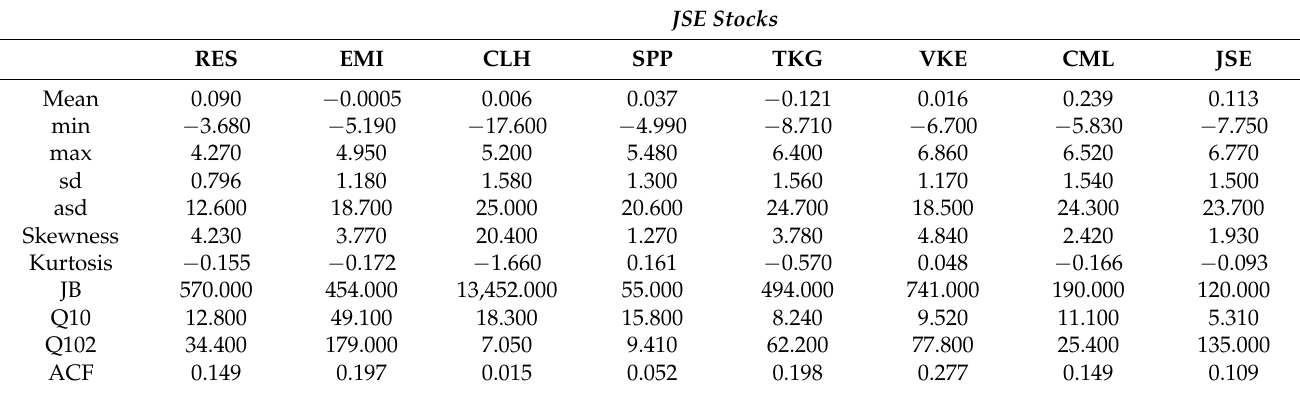
Table 1. Summary statistics of classified JSE stocks with lower behavioral scores.